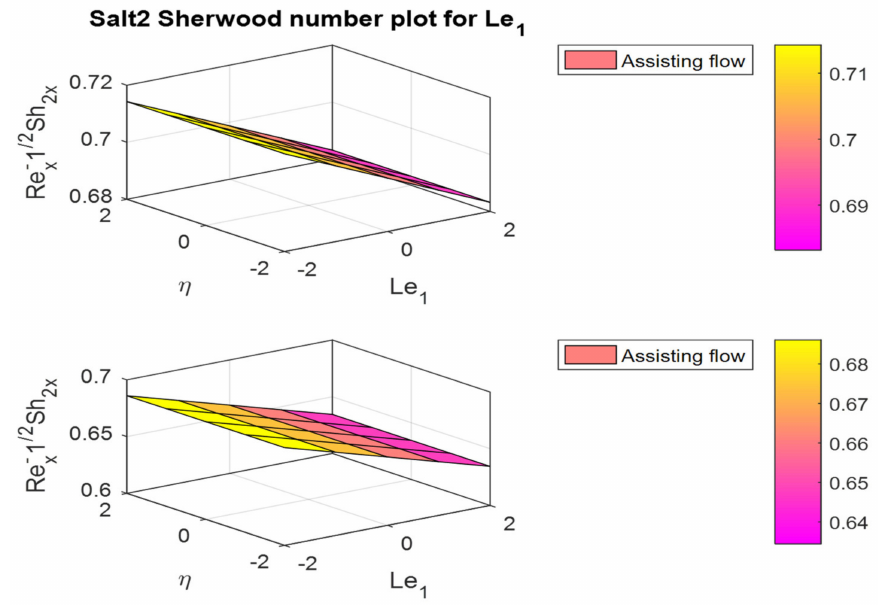
( 0 ) for dissimilar values of Le Figure 40. Surface plots for the φ (cid:48) 1 . 2 Figures 41–44 illustrate the shear stress, Nusselt number, and salts_1 and salt_2 Sher- wood number plots for different values of Lewis number Le 2 . Figure 41 shows that increas- (cid:48)(cid:48) ( ing values of Le 2 f 0 ) escalate in both fluid flow cases. The Nusselt number is decreased in both flow cases. Finally, the salt_1 Sherwood number decreased and the salt_2 Sherwood number increased in both assisting and opposing flow cases.